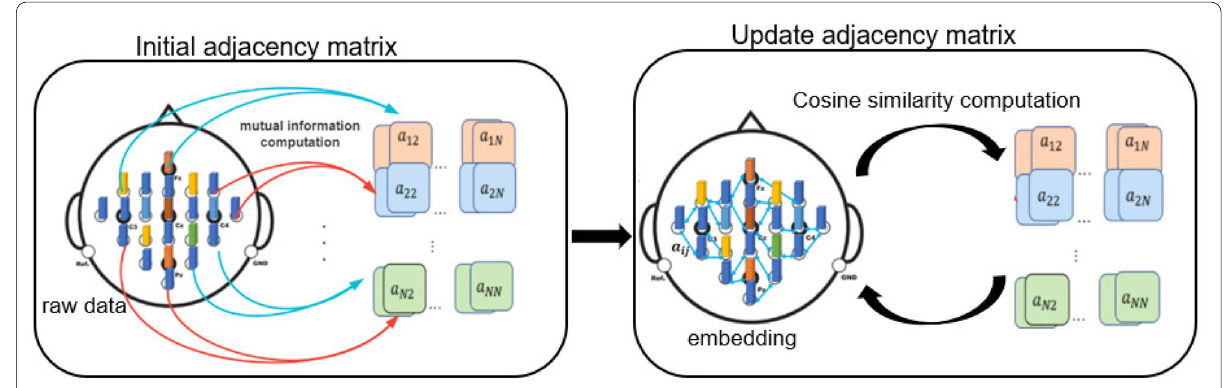
Fig. 3 The process of generating and updating the adjacency